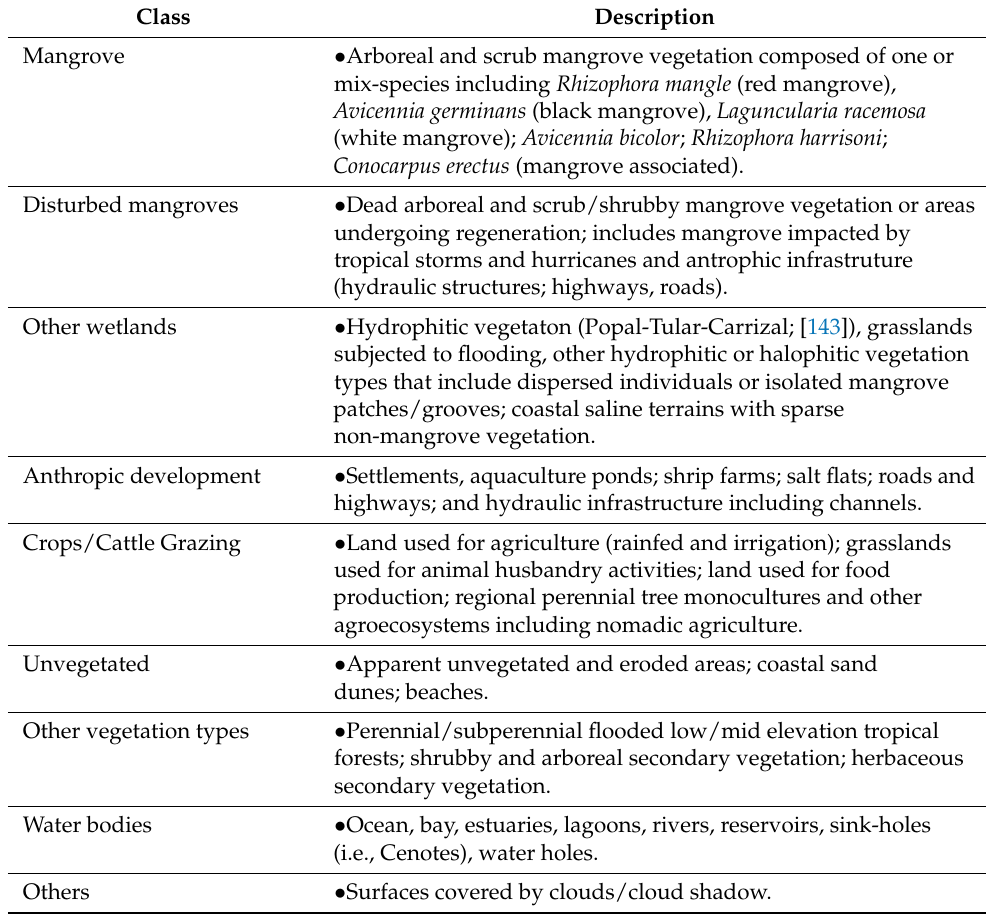
Table 2. Description of classes used in the SMMM to produce the cartography of both mangrove and adjacent land cover